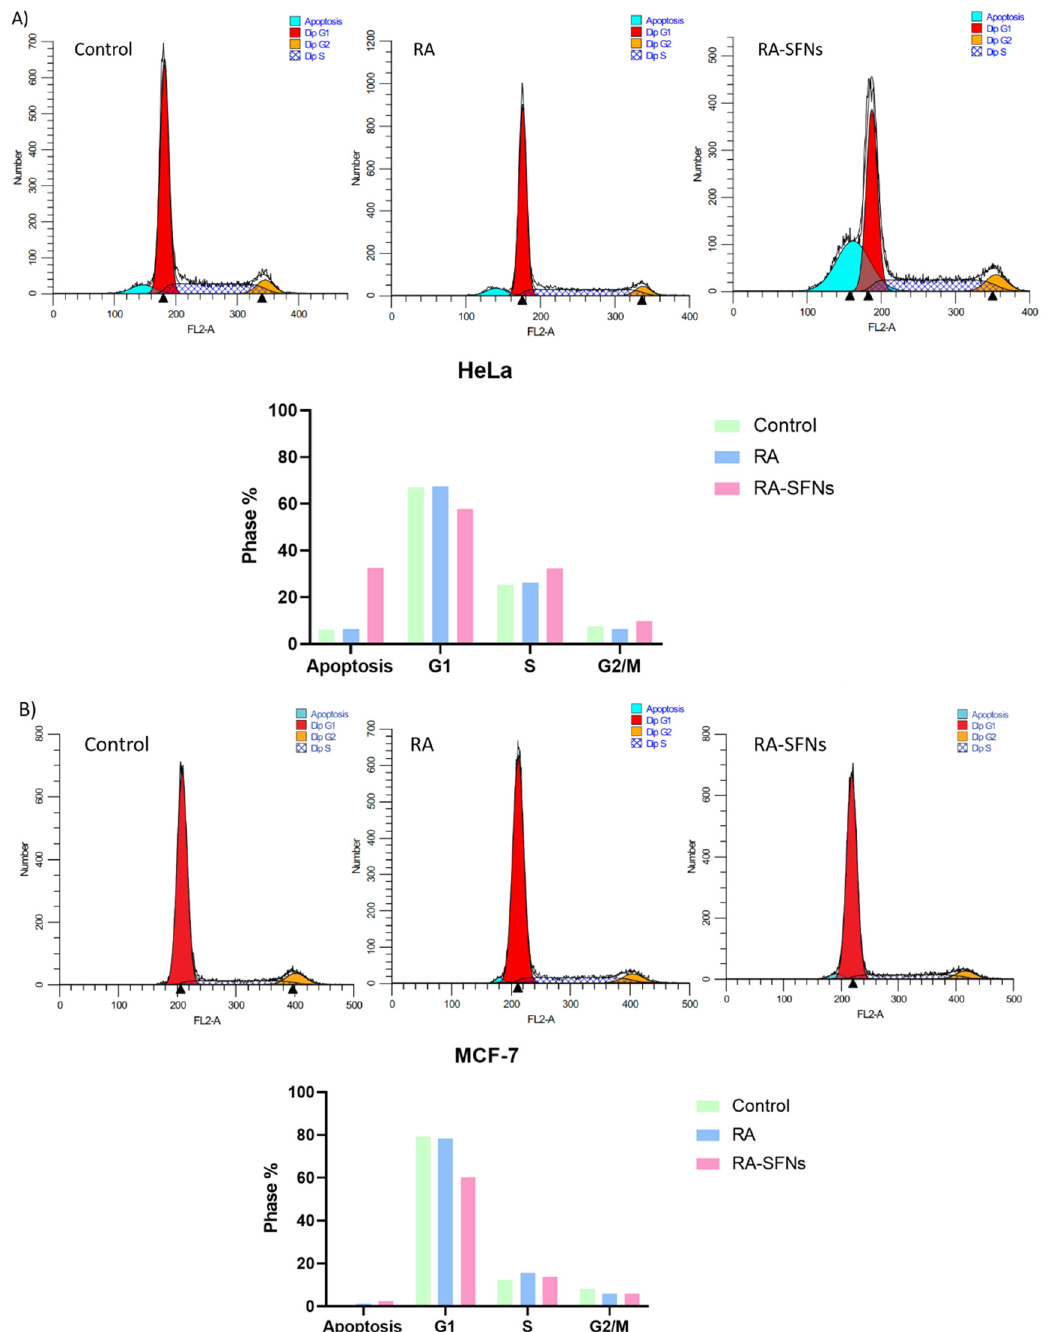
Figure 11. Cell cycle of HeLa ( A ) and MCF-7 ( B ) cells exposed to 0.226 mg/mL of RA and 2.4 mg/mL of RA-SFN for 24 h. Cells not treated were used as control.